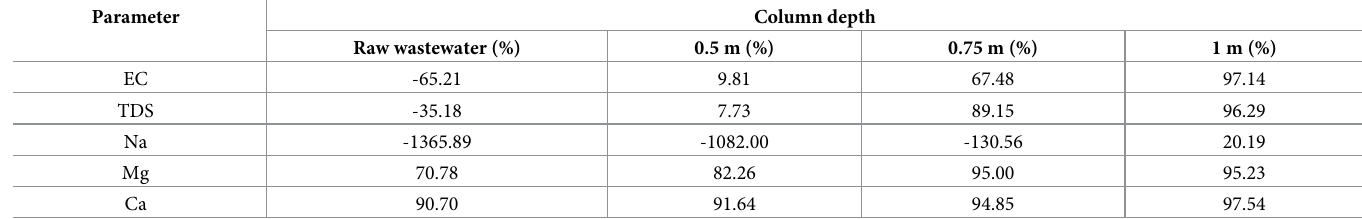
Table 10. Percent compliance from irrigation water quality standards.